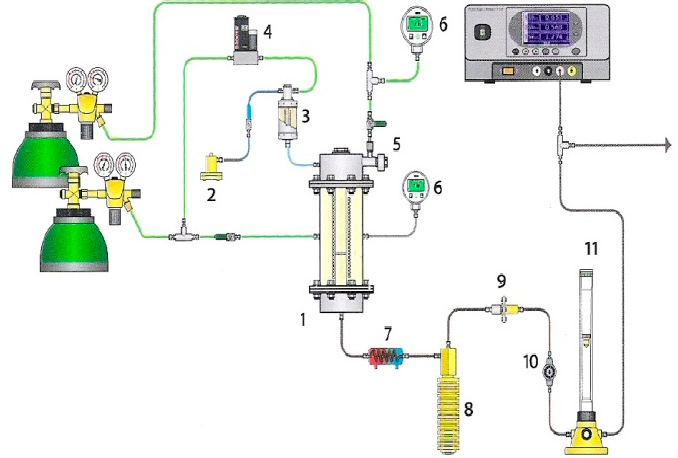
Figure 1. Laboratory equipment for examinations of gasification process: (1) fixed-bed reactor, (2) water pump, (3) steam generator, (4) mass flow meter, (5) fuel feeder, (6) manometer, (7) cooler, (8) condensate tank, (9) filter, (10) pressure regulator, and (11) rotameter.